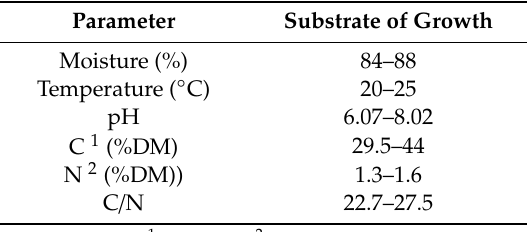
Table 2. Quality parameters of the growth substrate.